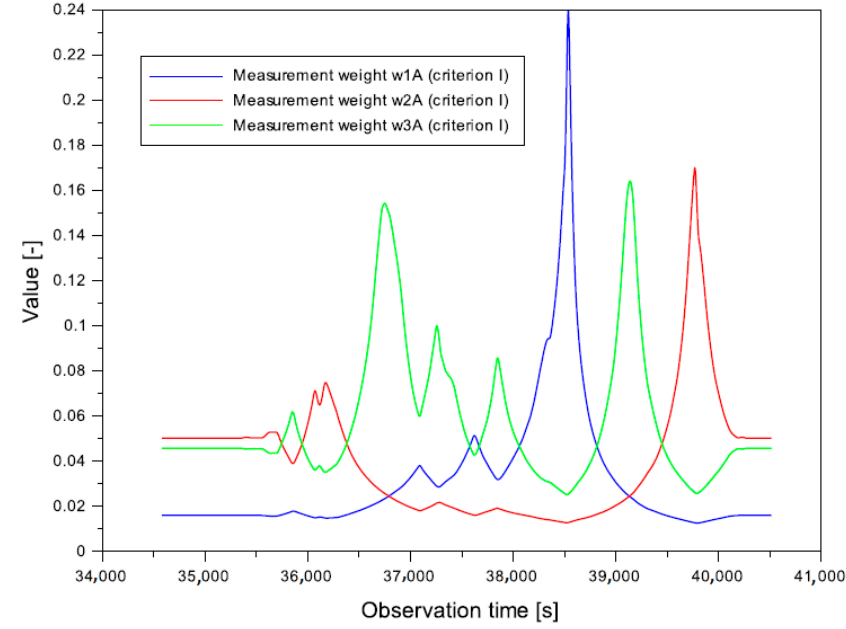
Figure 6. The measurement weights for criterion I.